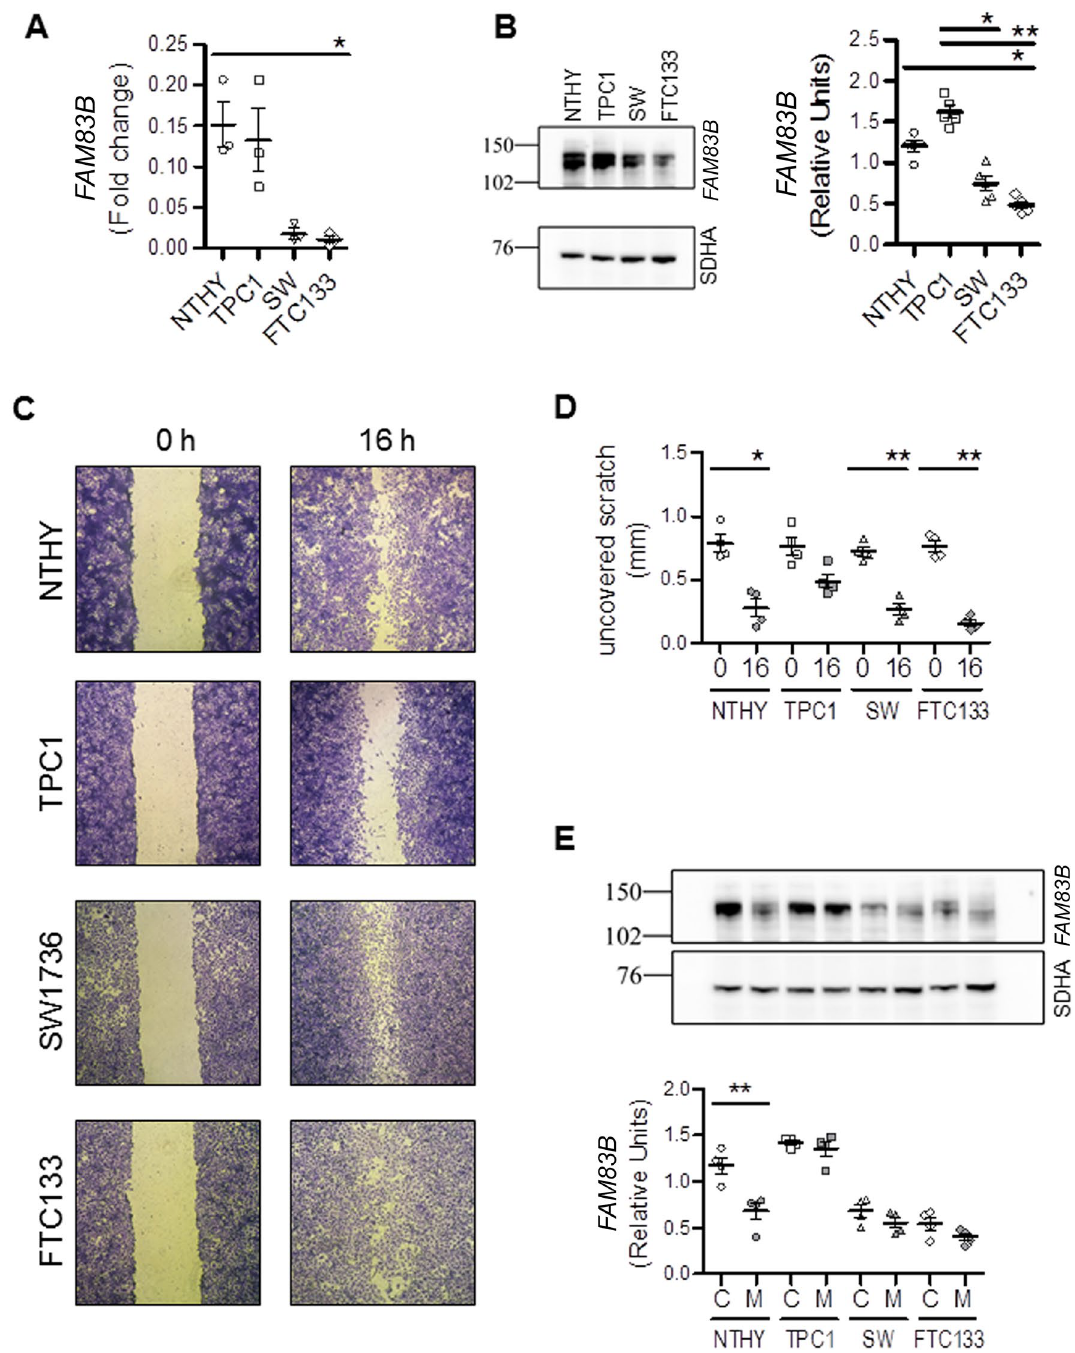
Figure 3. FAM83B levels in human thyroid cell lines recapitulate patient samples variations and are influenced by cell migration. ( A ) FAM83B mRNA levels in human cell lines derived from normal thyroid (NTHY-ORI), PTC (TPC1), ATC (SW1736) and FTC metastasis (FTC133). n = 3 for all cell lines. ( B ) Representative images and densitometric analysis of western blots showing FAM83B expression levels in the different human thyroid cell lines. SDHA was used as loading control. Data are shown as dot-plot with mean ± SEM. n = 5 for all cell lines. Full-length blot images are shown in Supplementary Fig. 4. ( C ) Representative images of a wound-healing assay showing the migration ability of the different human thyroid cell lines at the indicated times. ( D ) Quantification of uncovered scratch length of the wound healing assays. n = 4 for all cell lines. ( E ) Representative images and densitometric analysis of western blots showing FAM83B expression levels in bulk (C) and migrating (M) cells. SDHA was used as loading control. Data are shown as dot-plot with mean ± SEM. n = 4 for all cell lines. Full- length blot images are shown in Supplementary Fig. 4. Statistical analysis: ( A–E ) Kruskal–Wallis test followed by Dunn’s Multiple Comparison